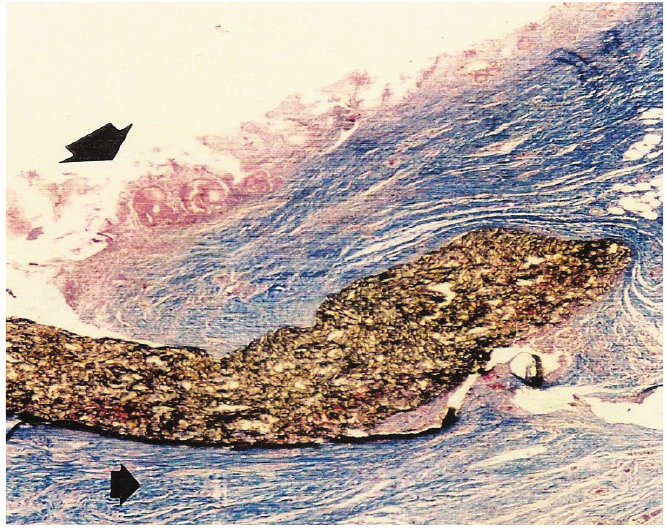
FIGURE 5 - Detail of the healing. Epithelial replacement of the duct wall by fibrosis (both arrows). The prosthesis was partially loosened into the lumen (x40,